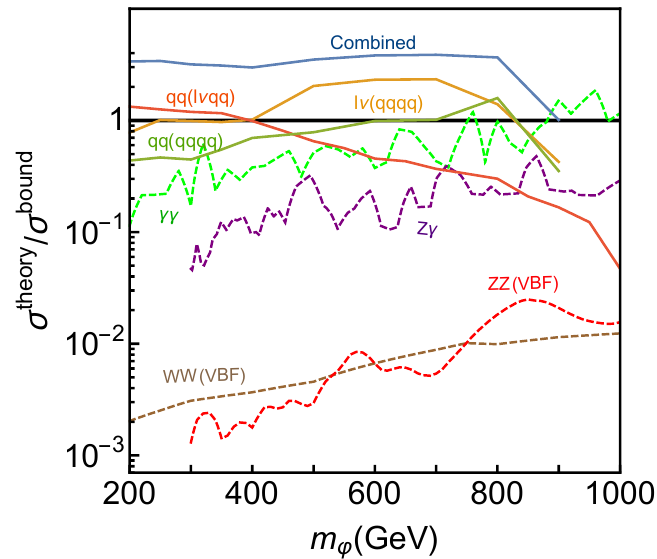
Figure 13. Comparison of search performance for searches dedicated to the direct production of ’ (dashed) vs searches dedicated for boosted production of a diboson jet (solid), extrapolated to 300 fb (cid:0) 1 as described in the text. We have (cid:12)xed m W a fraction of the predicted cross section in the warped model benchmark described in this